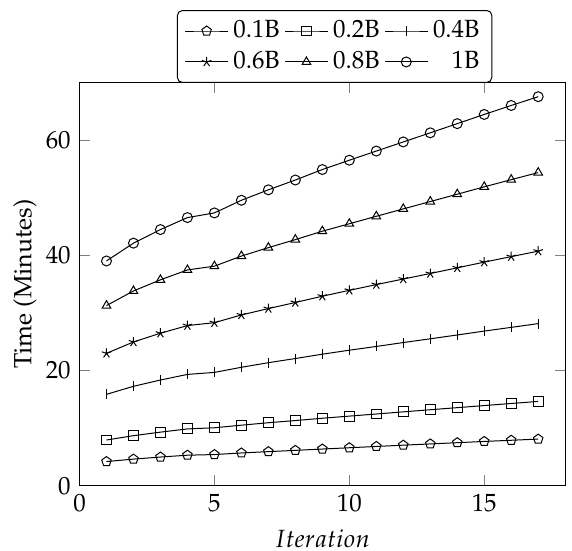
Figure 9. Performance of iteration against the # of